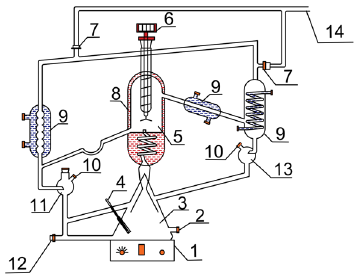
Fig. 1 The vapor–liquid double circulation balance kettle: 1-magnetic heating stirrer; 2-feeding port; 3-evaporation chamber; 4-thermom- eter; 5-equilibrium room; 6-thermocouple thermometer; 7-junction port; 8-insulation layer; 9-condenser chamber; 10-sampling port; 11-liquid-phase returning section; 12-discharge port; 13- vapor-phase returning section and 14-vacuum